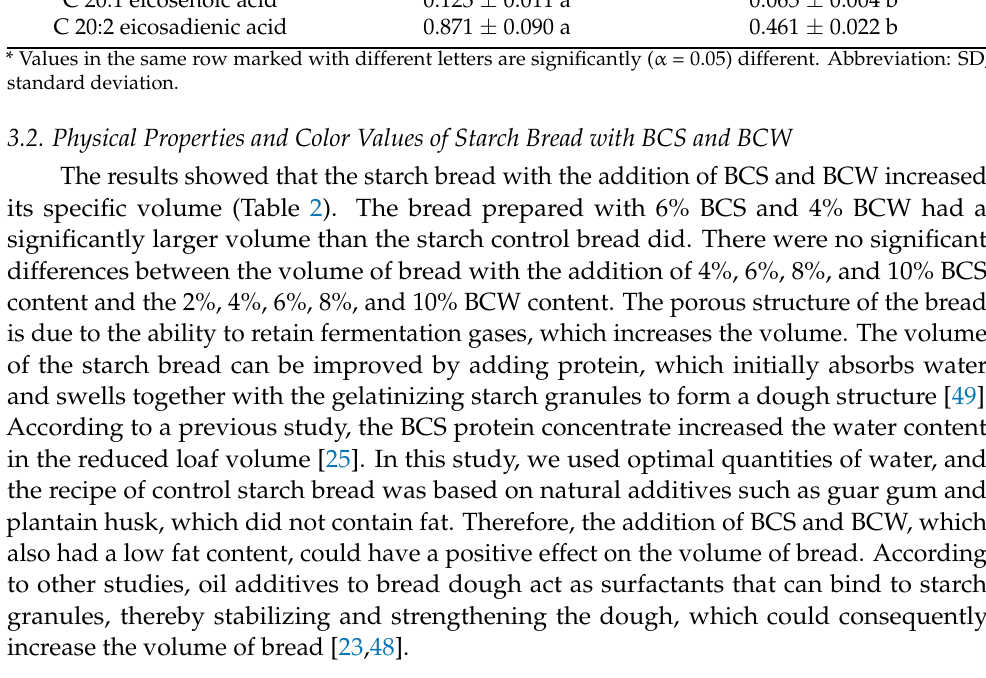
Table 2. Basic physical properties and crumb color values of